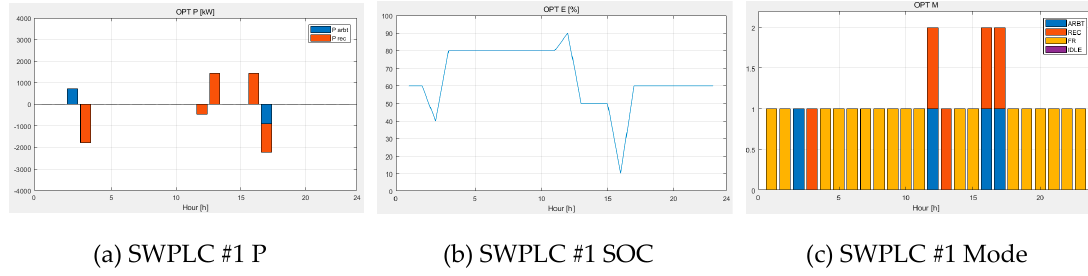
Figure 10. Scenario 5 simulation results.